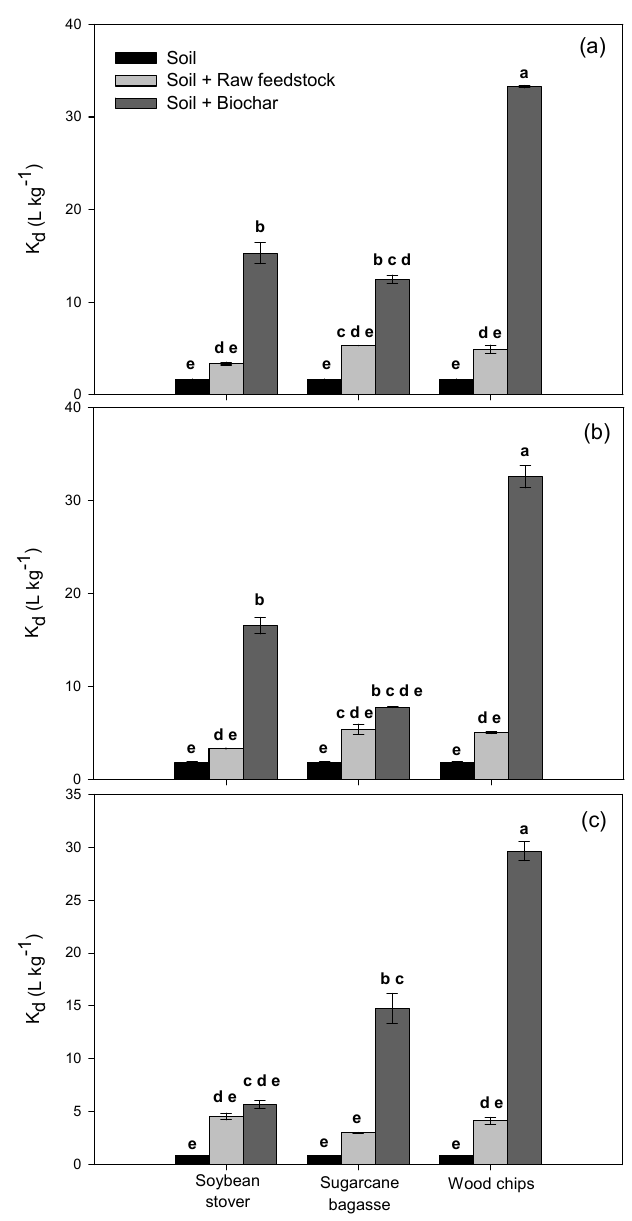
Figure 2. Alachlor sorption on ( a ) MN, ( b ) IL, and ( c ) PA soils with raw feedstock and biochar amendments (10% w / w ). Different letters indicate significant differences in K d values based on Tukey HSD comparisons.